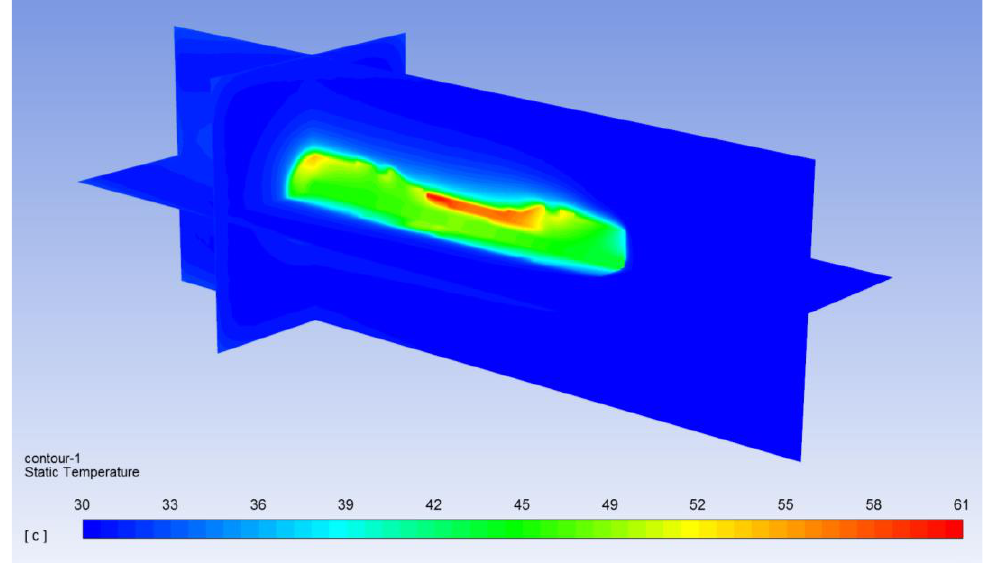
Figure 8. Temperature distribution around DC connector with current flow ( I = 15 A) and solar radiation. Max temperature: 61 °C.